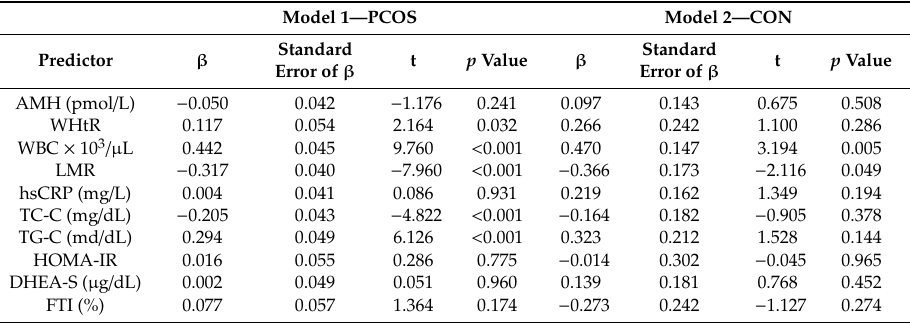
Table 8. Stepwise linear regression model for the assessment of monocyte-to-HDL ratio (MHR) in PCOS and CON